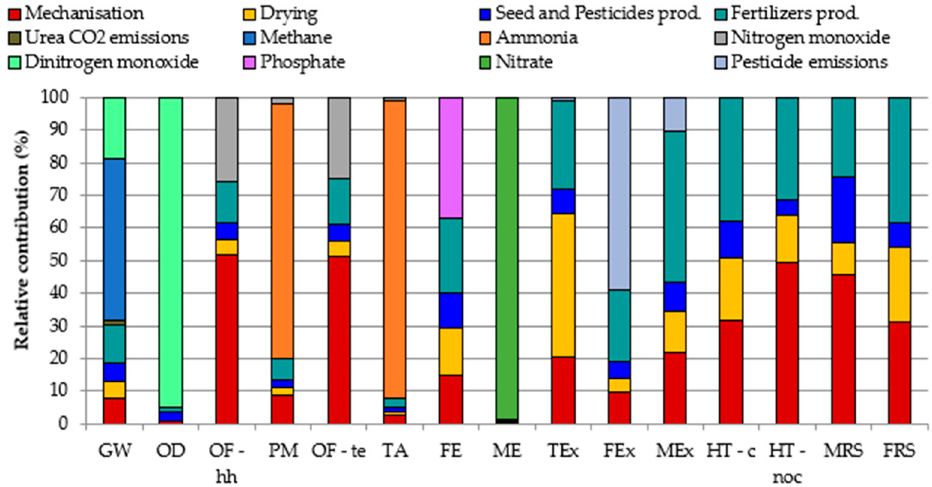
Figure 2. Relative contributions to the overall environmental impact of rice cultivation in the BS-21 scenario.